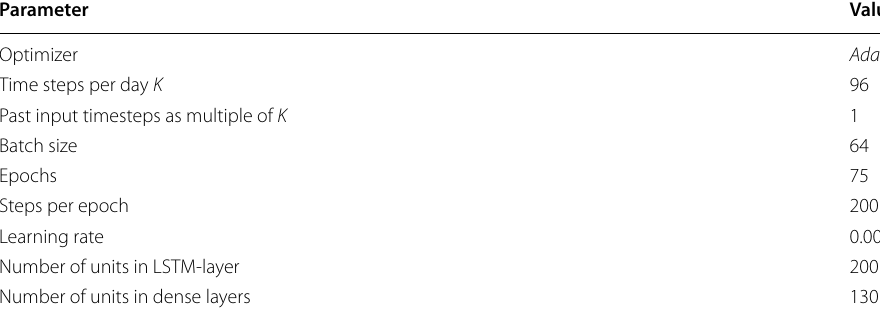
Table 5 Final LSTM parameters